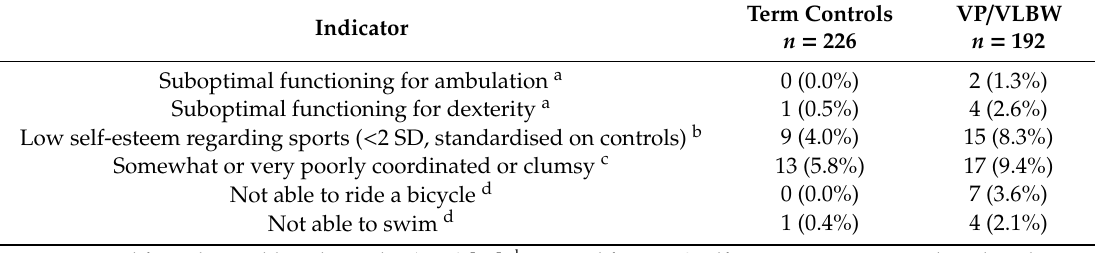
Table A1. Description of indicators for motor competence problems at 26 years. Indicator